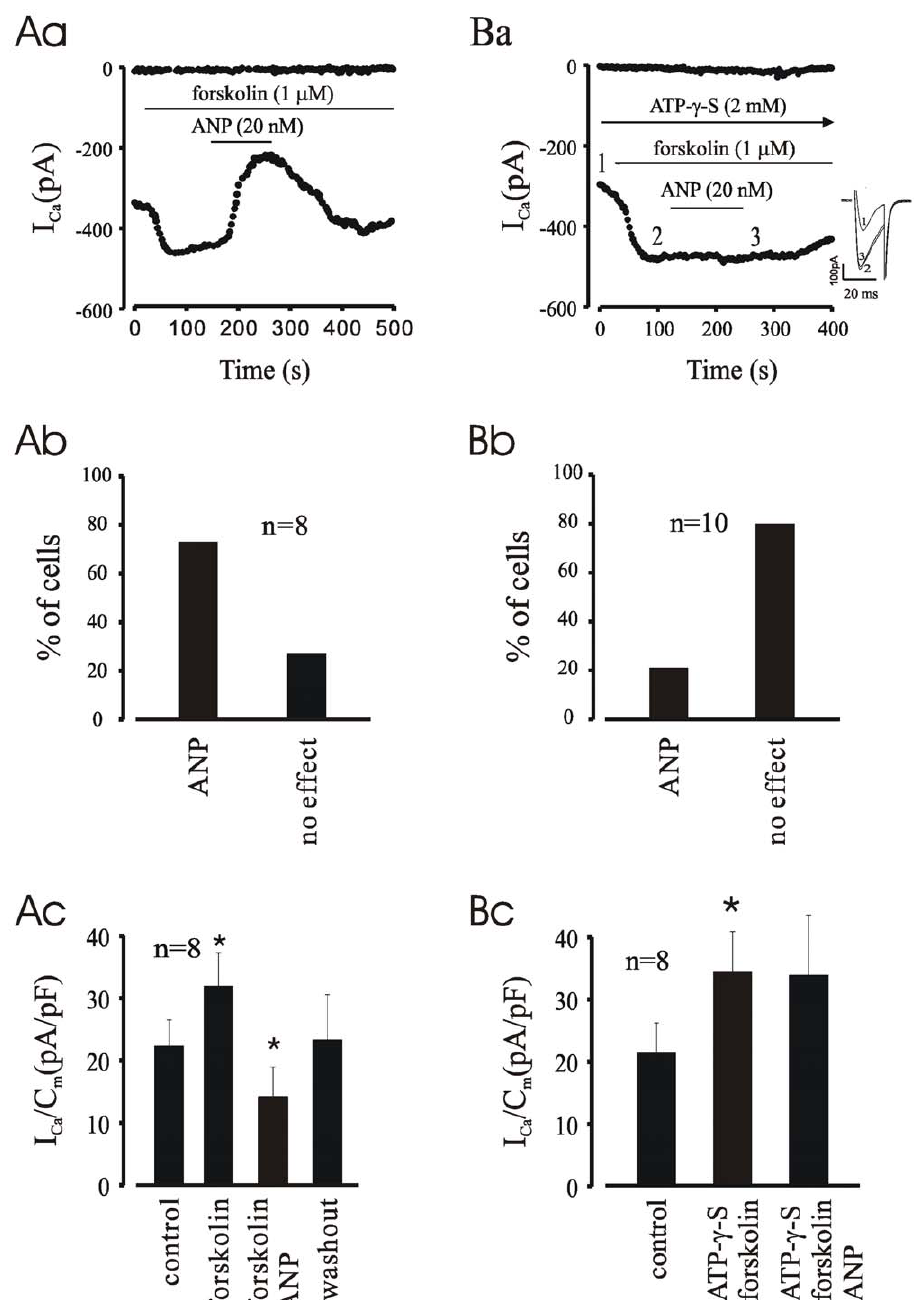
Figure 5. Effect of ATP- c -S plus forskolin on ANP induced I CaL inhibition. Aa , time course shows that ANP depressed forskolin pre- stimulated I CaL, however the depressed effect of ANP on forskolin pre-stimulated I CaL was abolished in the presence of ATP- c -S ( Ba ). The insets are traces recorded in the same cells as time courses. Ab & Bb , percentage of cells with or without responding to ANP. Ac & Bc , density of peak I CaL . *P , 0.05 compared with control. doi:10.1371/journal.pone.0008847.g005 cGMP is a good candidate to mediate the inhibitory effect of ANP on basal I Ca,L . cGMP could inhibit I CaL via either cGMP- dependent protein kinase (PKG) [32] or via activation of cAMP hydrolysis via stimulation of the cGMP-stimulated PDE2 [20,33].